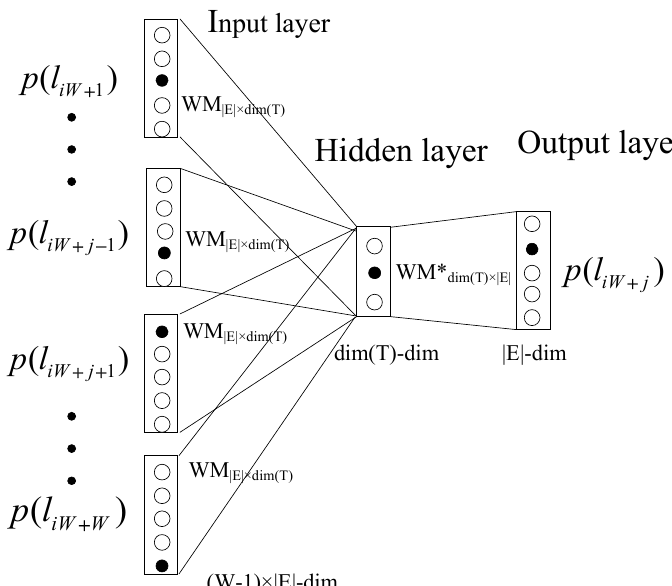
Figure 3. Log event as input of the word2vec model. The target is log event p ( l iW + j ) , and the rest log events p ( l iW + 1 ) , p ( l iW + 2 ) , . . . , p ( l iW + j − 1 ) , p ( l iW + j + 1 ) , . . . , p ( l iW + W ) in the log sequence lse i are taken as